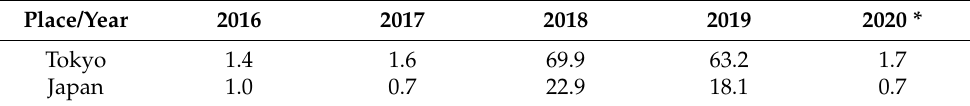
Table 2. Reported rubella cases per million, by prefecture [16,18,19].